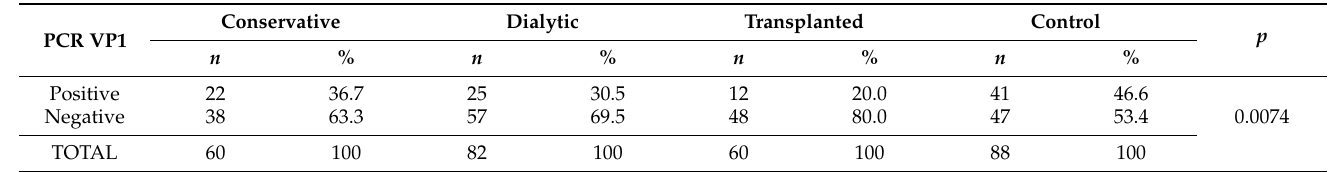
Table 2. Prevalence of polyomavirus in the chronic kidney population by conservative, dialysis, and transplanted groups compared to the control group in Bel é m, Par á , Brazil, 2016.